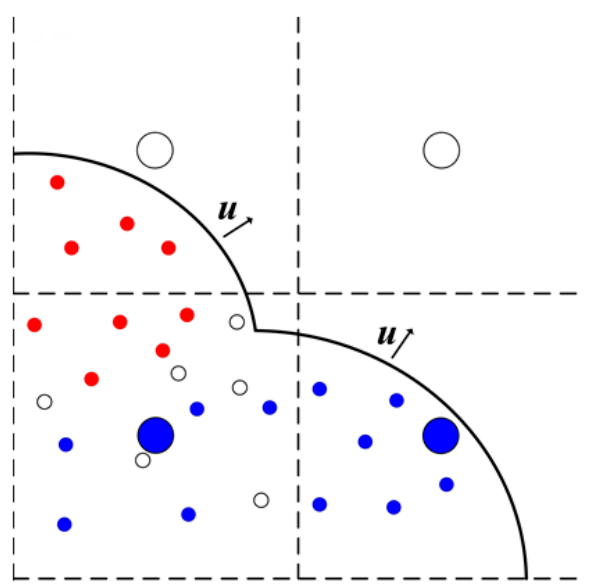
Figure 3. Schematic representations of the uncolored and reseeding particles in the lower-left cell where there exists different colored particles.